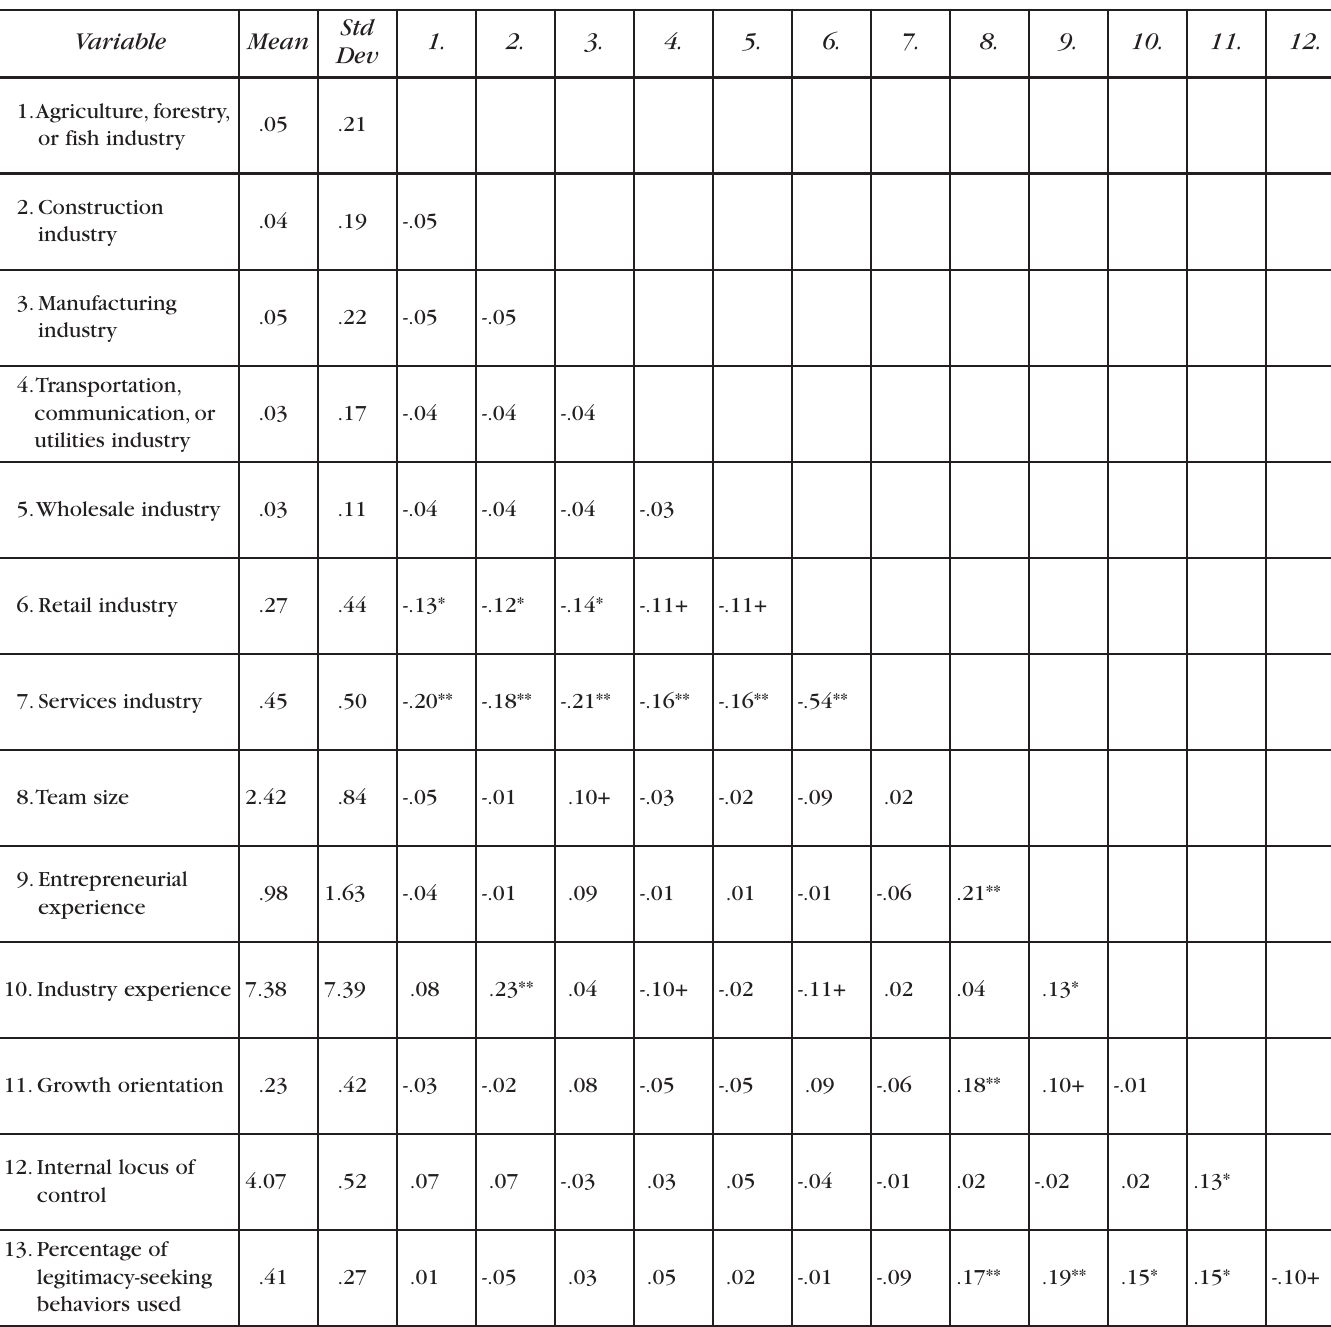
Table 1. Descriptive Statistics and Correlations among Study